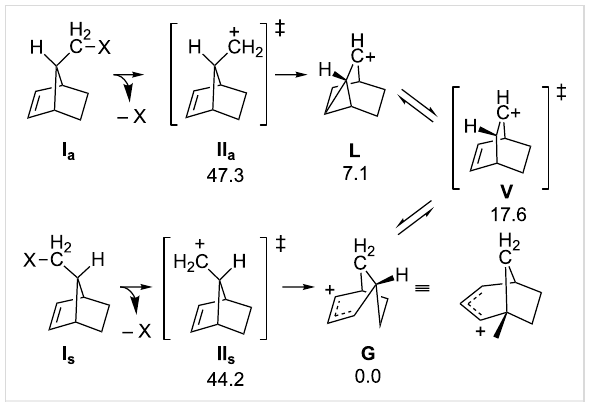
Figure 6: The portion of the norborn-2-en-7-ylmethyl cation PES ex- amined by Ghigo et al. [60]. Energies reported are electronic energies, including zero-point corrections (ZPE), at the B3LYP/6-31G(d) level of theory and are all relative to that of G [61-63].